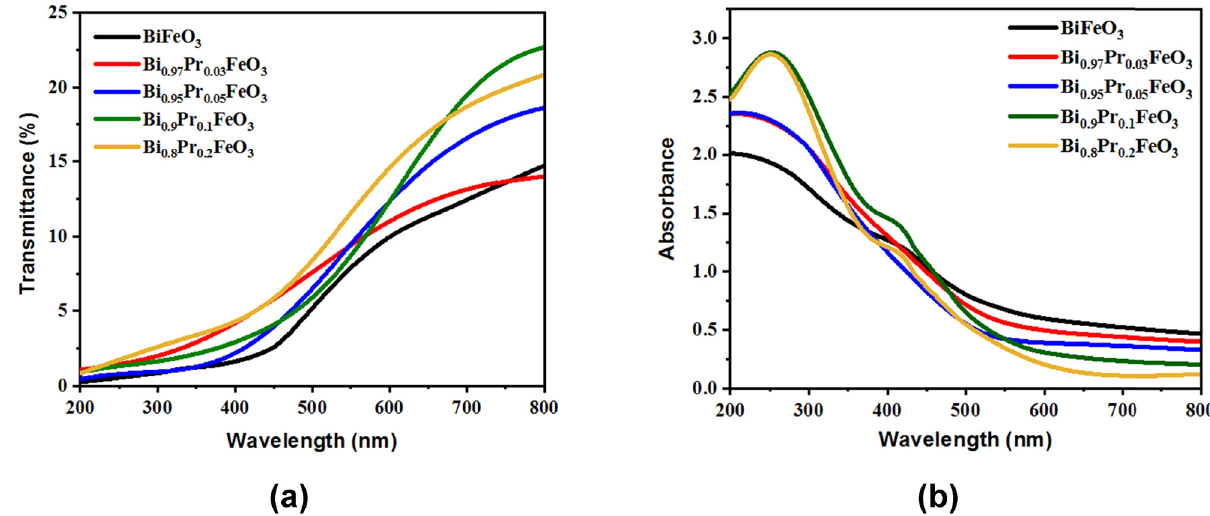
Figure 5: ( a ) Transmittance ( T ) and ( b ) absorbance ( A ) spectra of BiFeO 3 and Bi 1 − x Pr x FeO 3 fi